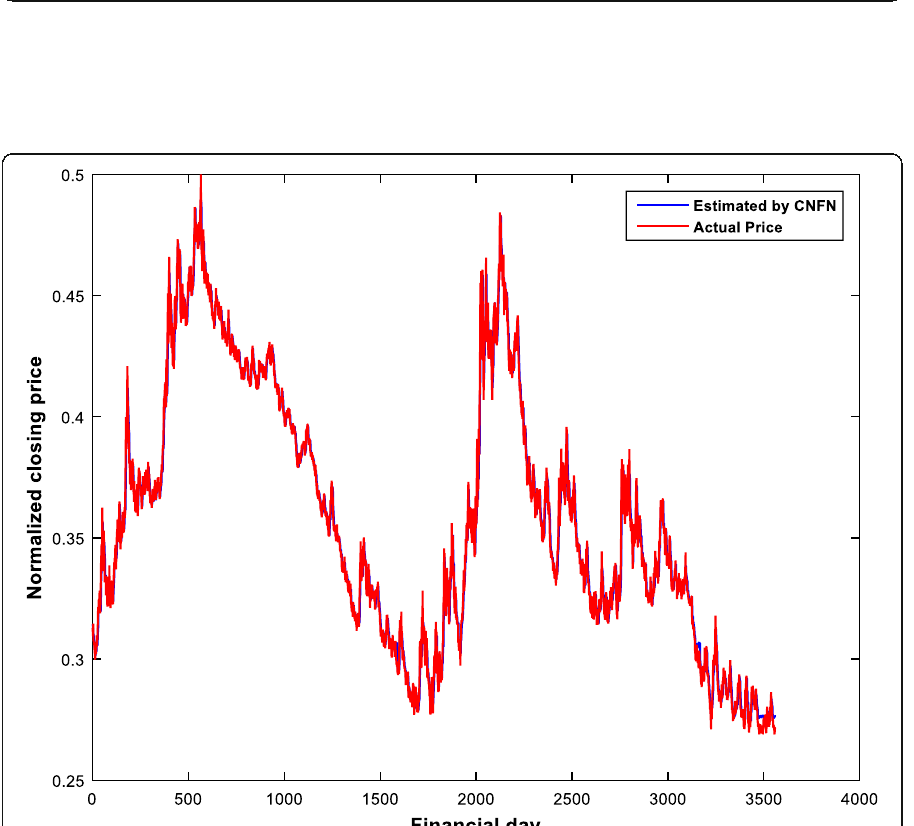
Fig. 17 Estimated v/s actual closing prices by CNFN forecasting model for FTSE stock market